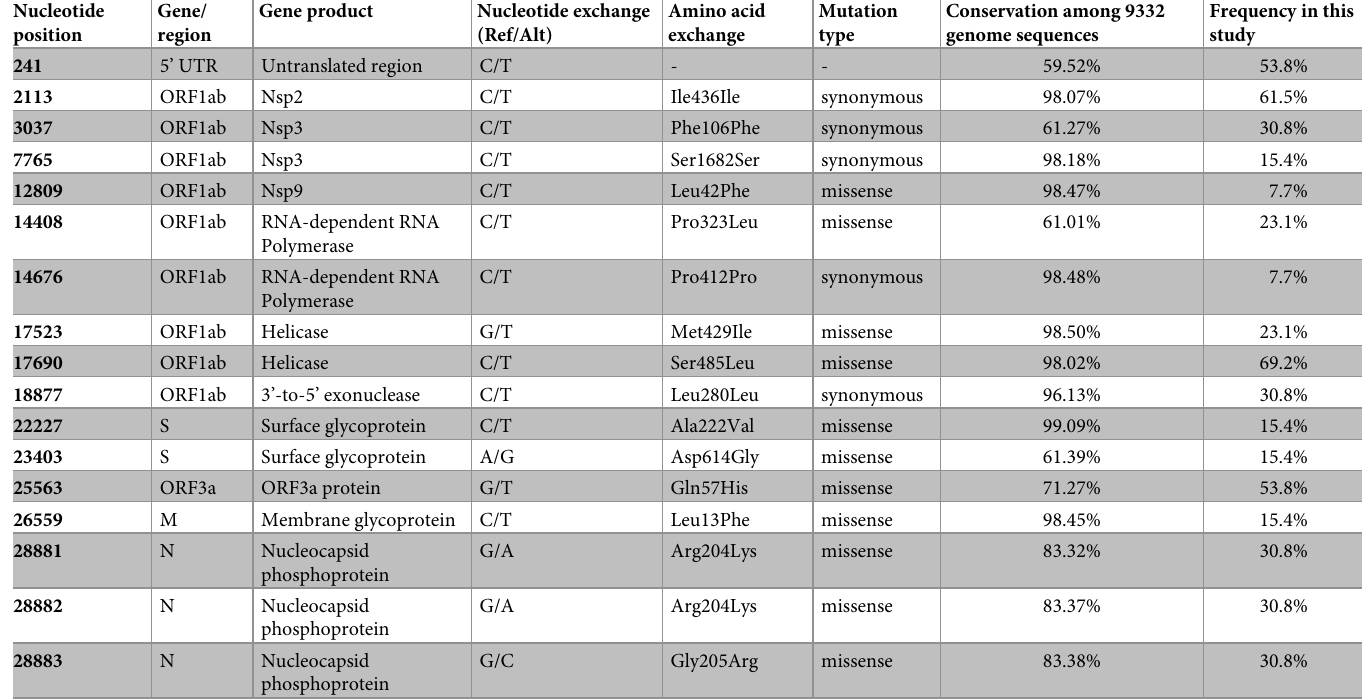
Table 2. Detailed information on detected mutations.